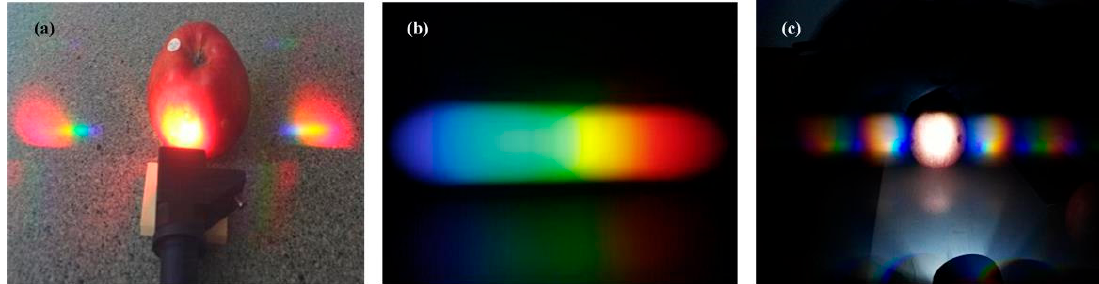
Figure 2. ( a ) Using flashlight to illuminate an apple sample; ( b ) the rainbow from the diffraction grating sheet; ( c ) the experimental condition and reflected rainbow images.